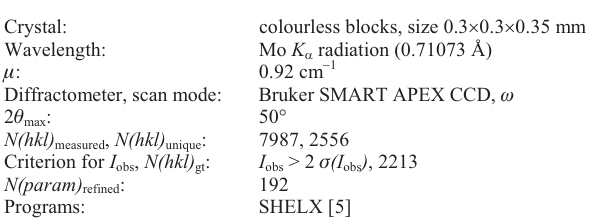
Table 1. Data collection and handling.